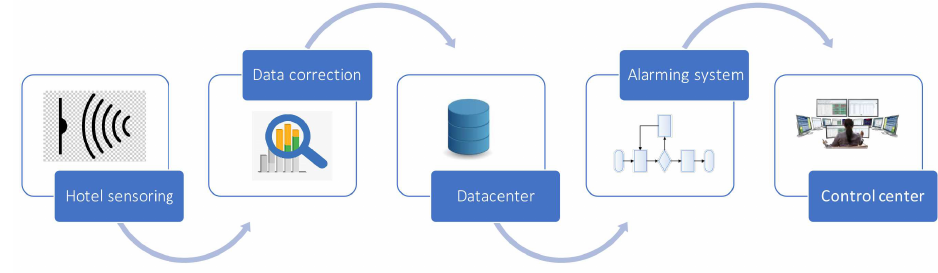
Figure 16. Proposal of architecture for the intelligent system to detect consumption anomalies in a